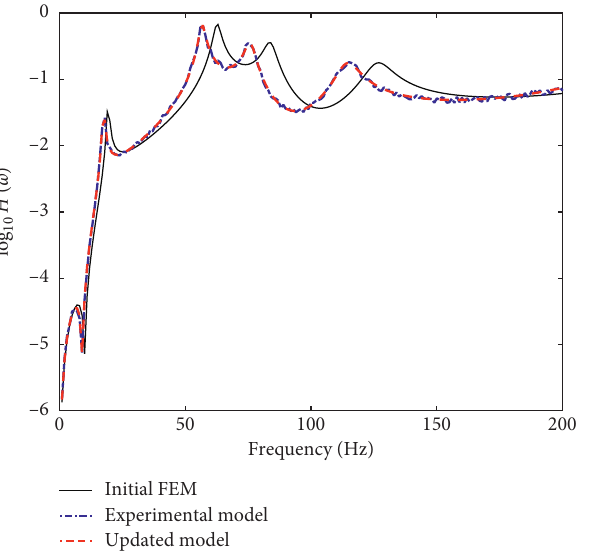
Figure 7: Result of FEMU.